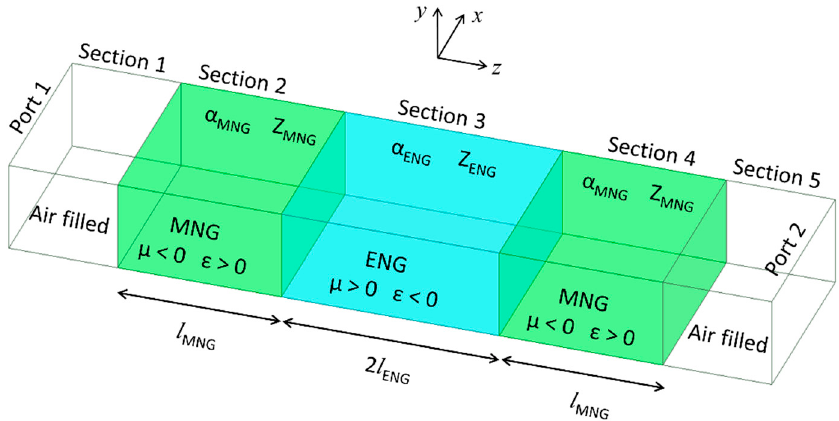
Figure 2. Schematic of a cascade of MNG, ENG and MNG metamaterial filled waveguide where tunneling (transmission from port 1 to port 2 or vice versa) is possible under certain conditions. (In color.).